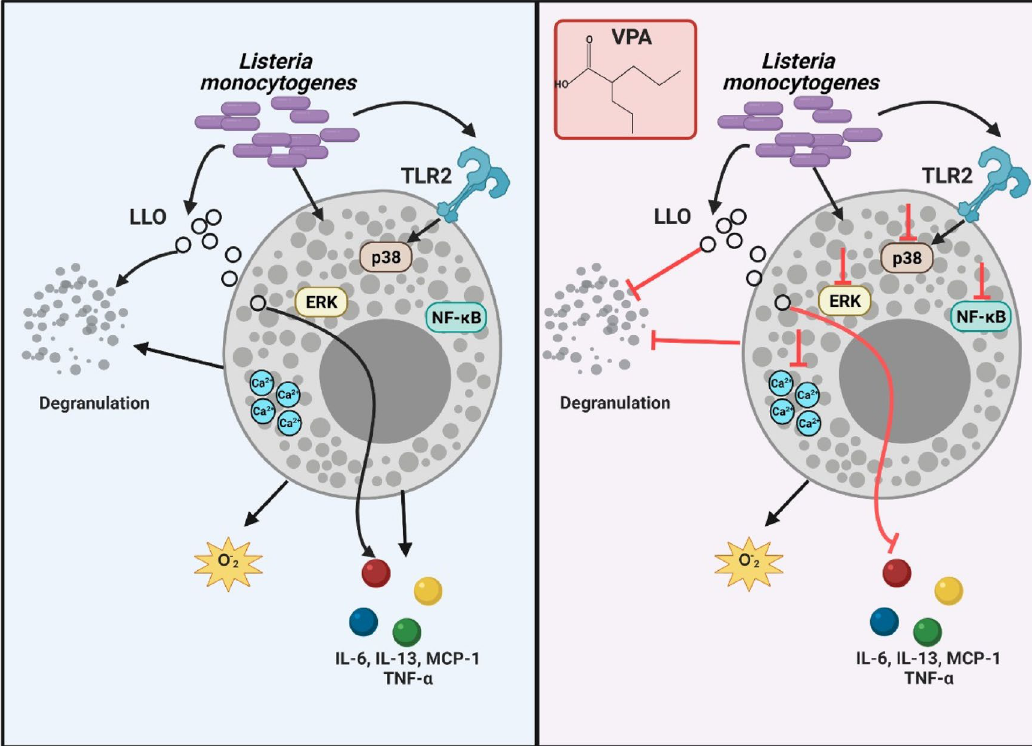
Figure 5. Valproic acid affects Listeria monocytogenes -mediated mast cell activation. Mast cells (MC) degranulate, produce superoxide anion (O - 2 ) and secrete cytokines such as IL-6, IL-13, CCL2, and TNF in response to Listeria monocytogenes (L.m) infection. In addition, this pathogen induces MC intracellular Ca 2+ mobilization and the activation of NF-κB (p65) and MAPK, ERK 1/2 and p38, the latter being dependent on TLR2-mediated signaling. In addition, Listeriolysin O (LLO) secreted by L.m induces MC degranulation and cytokine production (left panel). Pre-incubation of MC with valproic acid (VPA) affects MC degranulation, cytokine synthesis, intracellular Ca 2+ mobilization and NF-κB, ERK 1/2 and p38 phosphorylation in response to L.m, as well as MC degranulation and cytokine production in response to LLO. Noteworthy, in this model VPA does not affect O - 2 production, cell surface TLR2 expression (right panel). This figure was created with